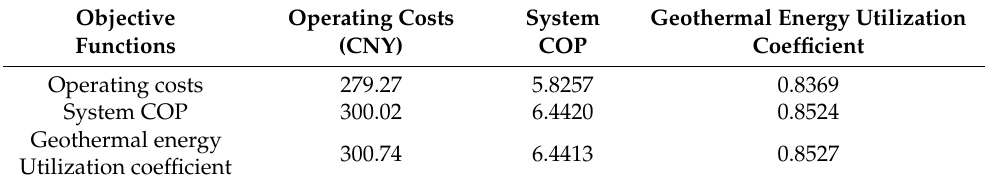
Table 2. Evaluation indicators of the system after optimization with different objective functions.